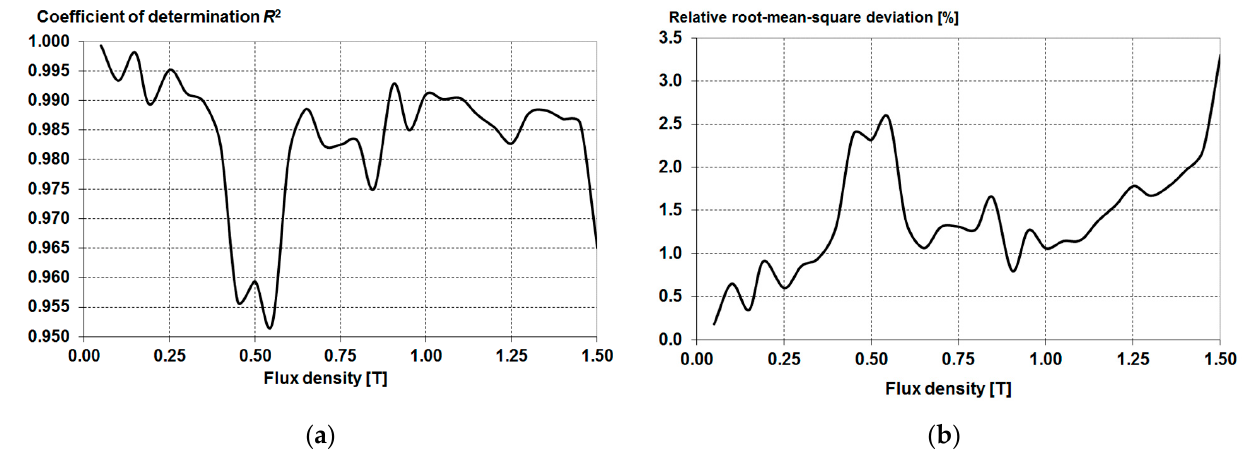
Figure 2. ( a ) The values of the coefficient of determination for the linear approximation R 2 for individual flux density values; ( b ) The values of the relative mean square error for the linear function approximation for individual flux density values.